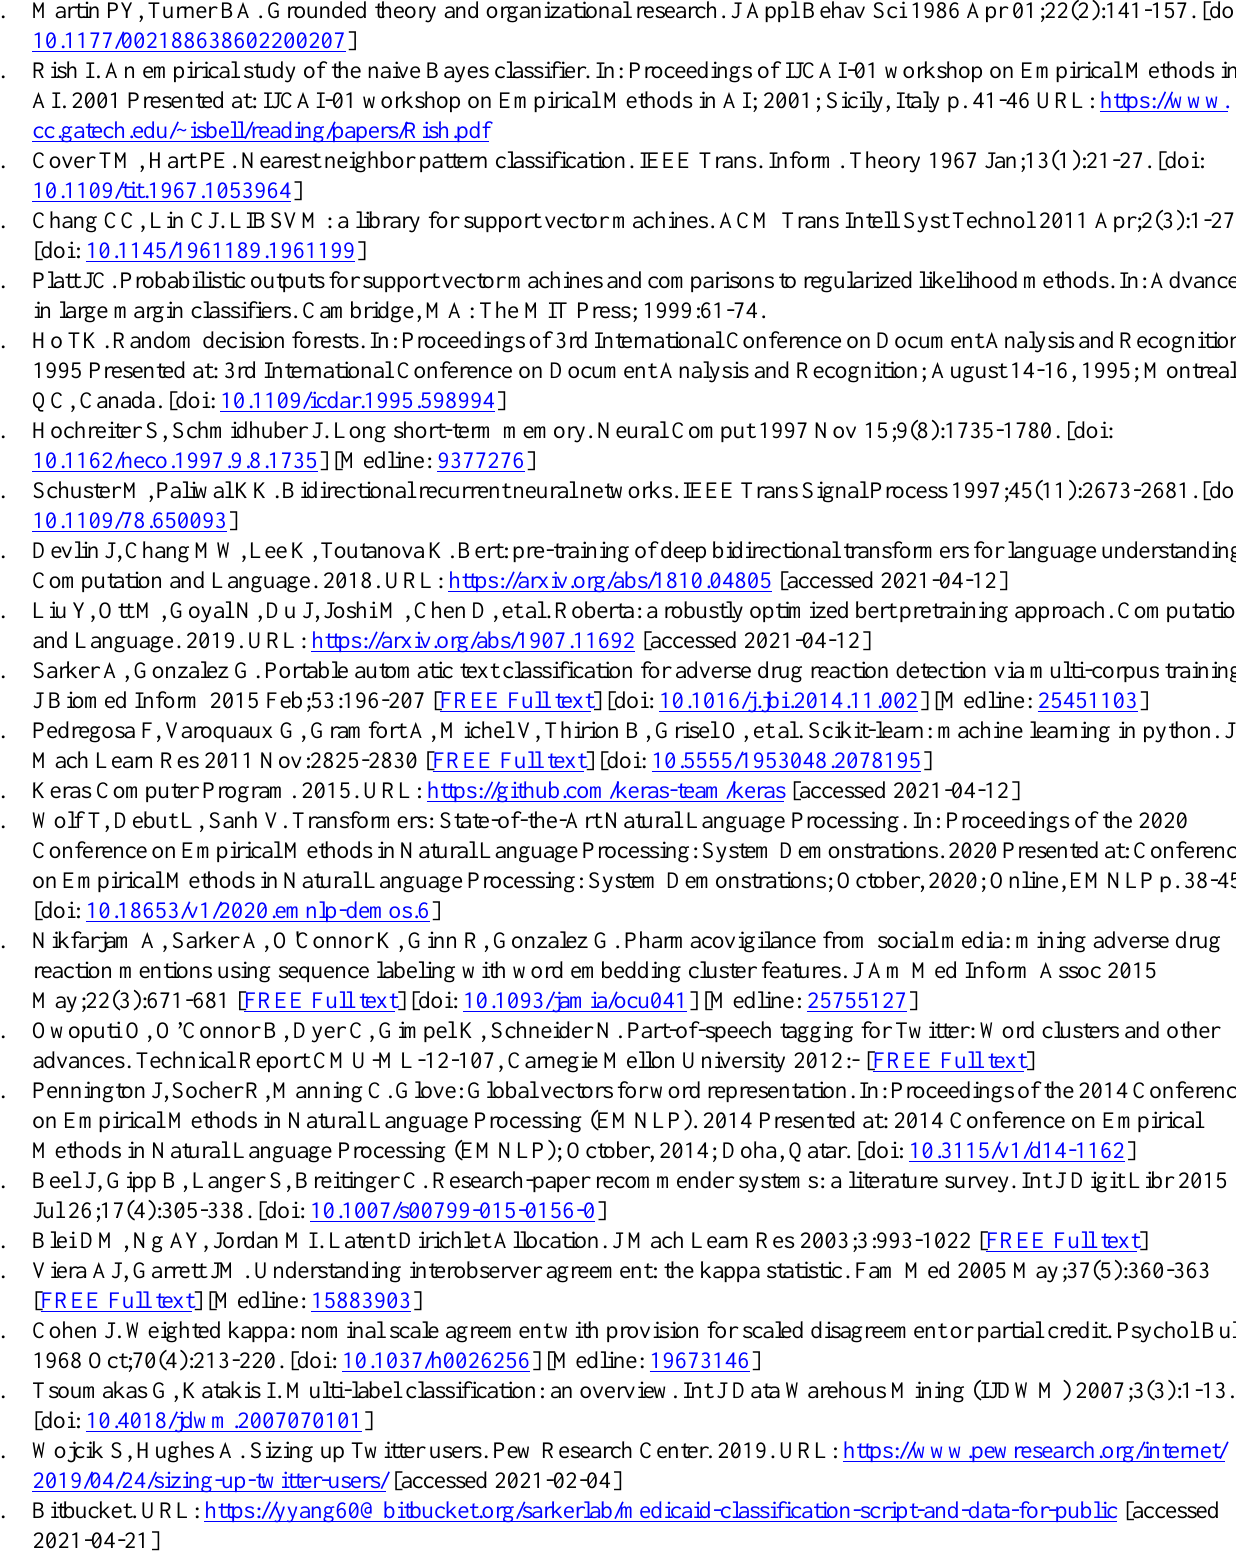
BERT: bidirectional encoder representations from